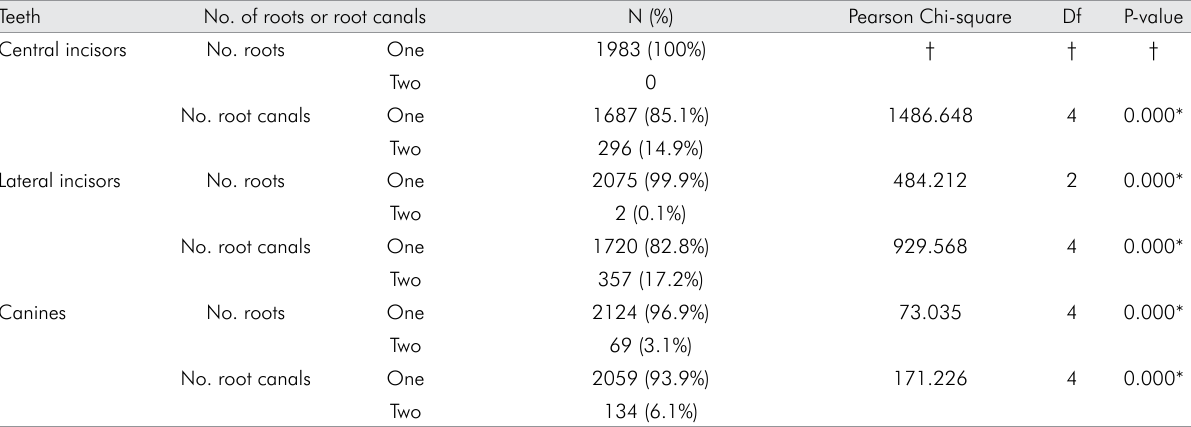
Table 1. Distribution of the numbers of roots and root canals in the mandibular anterior teeth, and statistical results.